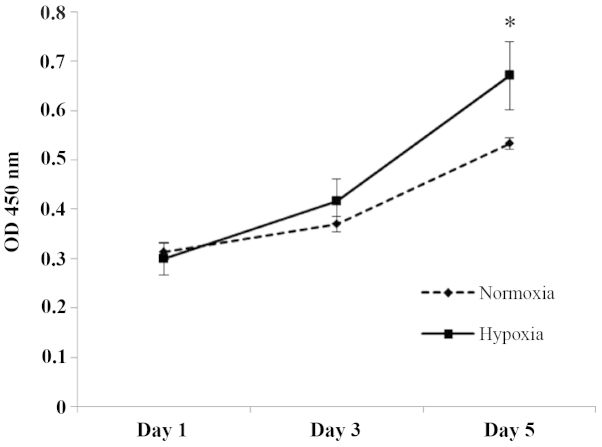
Effects of hypoxia on cell proliferation over the period of 5 days in RMCCA-1 cells are shown. (♦) Normoxia and (■) hypoxia; *P<0.05 vs. normoxia. Values are expressed as the mean ± standard deviation (n=3). OD, optical density.